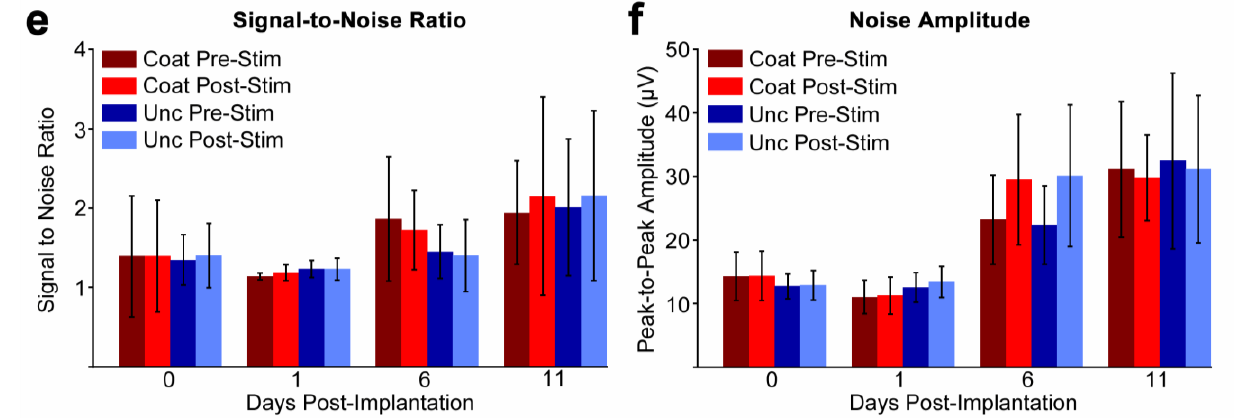
Figure 4. ( a – d ) Representative unit recording from a PEDOT/MWCNT/Dex-coated electrode at day 11 post-implantation. Red line indicates onset of visual stimulus. ( a ) Filtered (300 Hz–3 kHz) data stream; ( b ) Two example units sorted from the same coated electrode; ( c ) Peristimulus time histogram (PSTH) for each respective unit.; ( d ) Interspike interval (ISI) histogram of the two example units; ( e ) Average signal-to-noise ratio (SNR) values